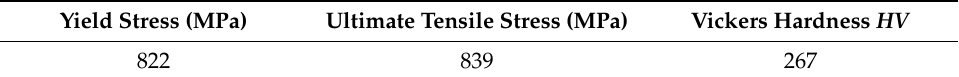
Table 1. Chemical composition of HT780 (mass %). Table 2. Mechanical proparties of HT780. Table 2. Mechanical proparties of HT780.